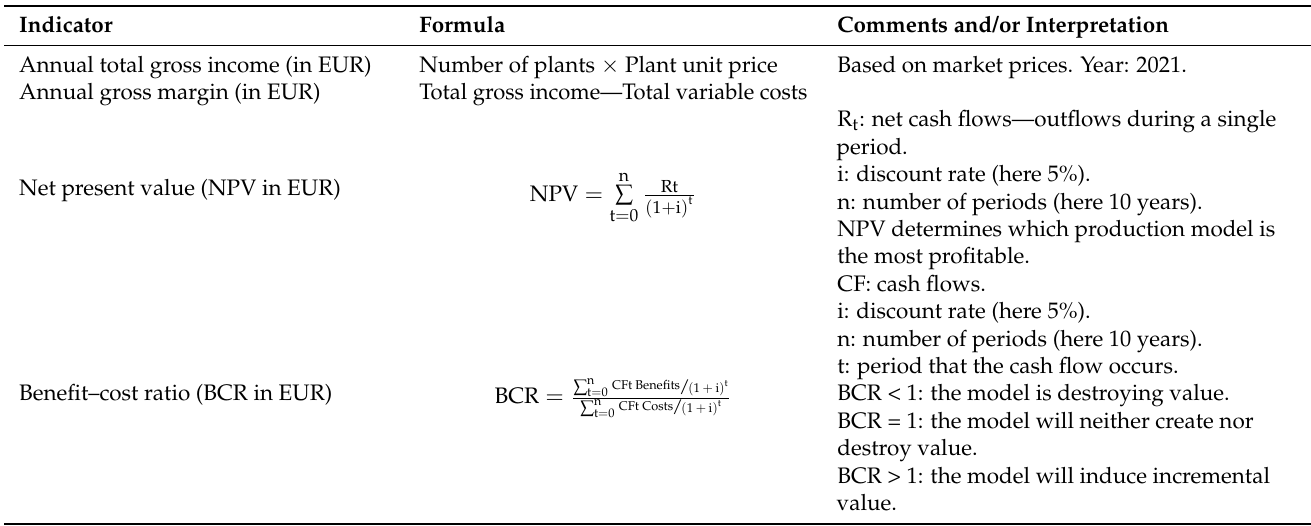
Table 5. Financial indicators used to assess the economic viability of the two ornamental production models: conventional production model (CM) and novel and sustainable production model (NSM), among 8 selected ornamental species. Formula Comments and/or Interpretation Number of plants × Plant unit